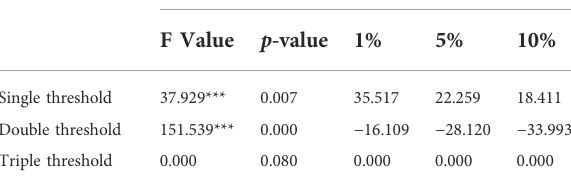
TABLE 1 Double threshold estimate and con fi dence interval. TABLE 2 Threshold effect test